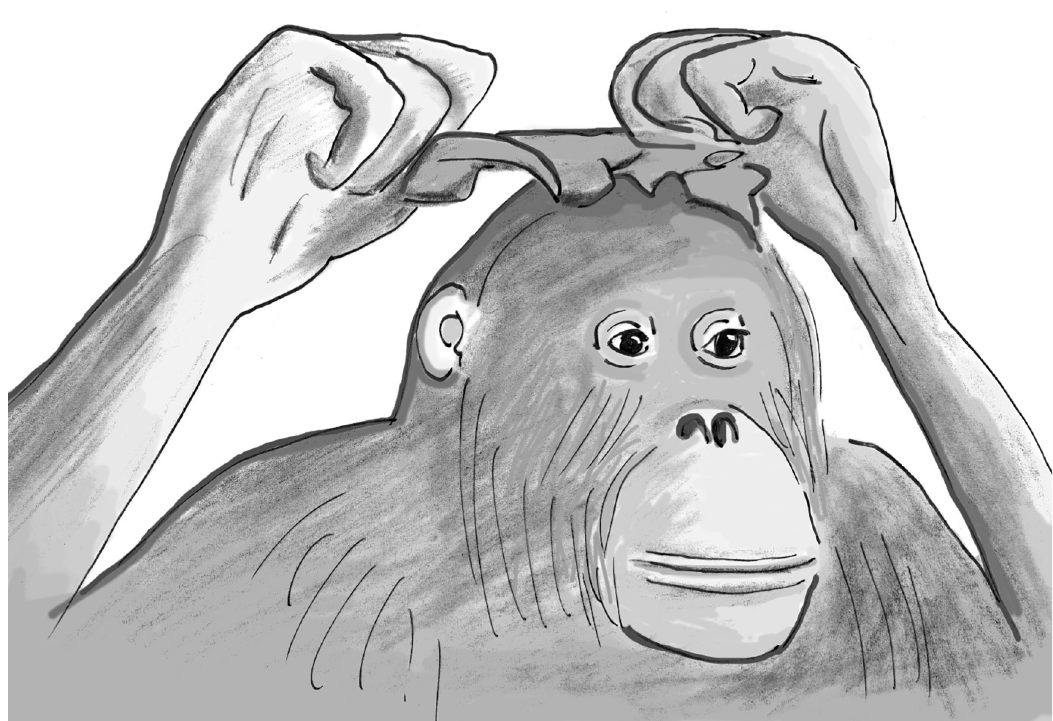
Fig 4. Mirror-guided self-decoration by an ape. Suma, an orangutan at a German zoo, often embellished herself in front of a mirror, such as by putting a leaf of lettuce onto her head like a hat while staring at her reflection. Drawing by Frans de Waal [19] based on